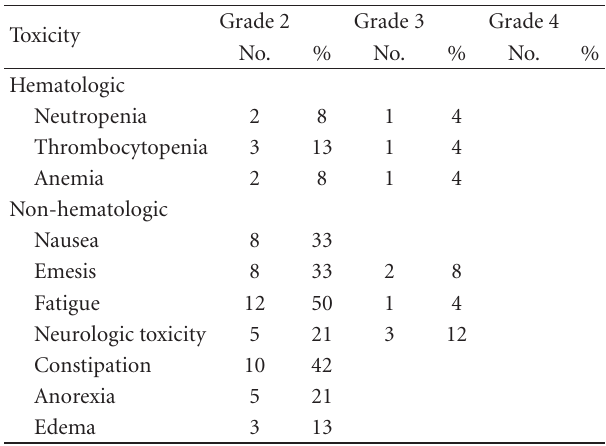
Table 3: Most common or serious hematologic and nonhemato- logic